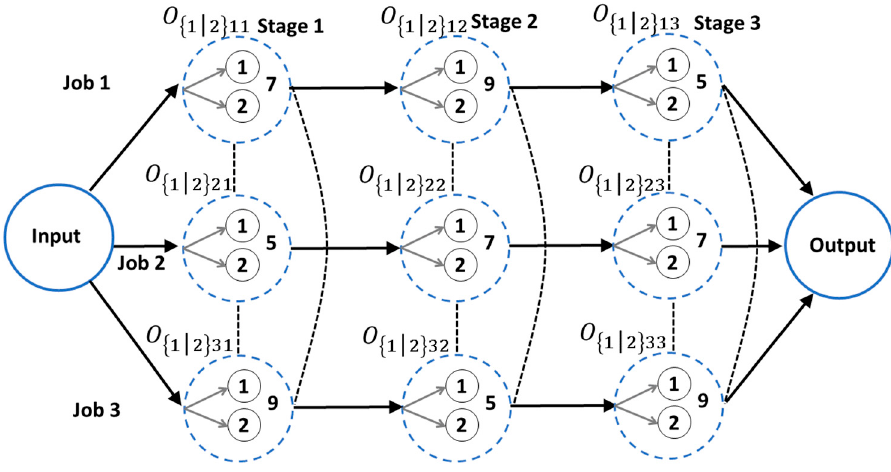
Figure 1. A disjunctive graph representing a RFFSP with three jobs, three stages, and two machines by stage.